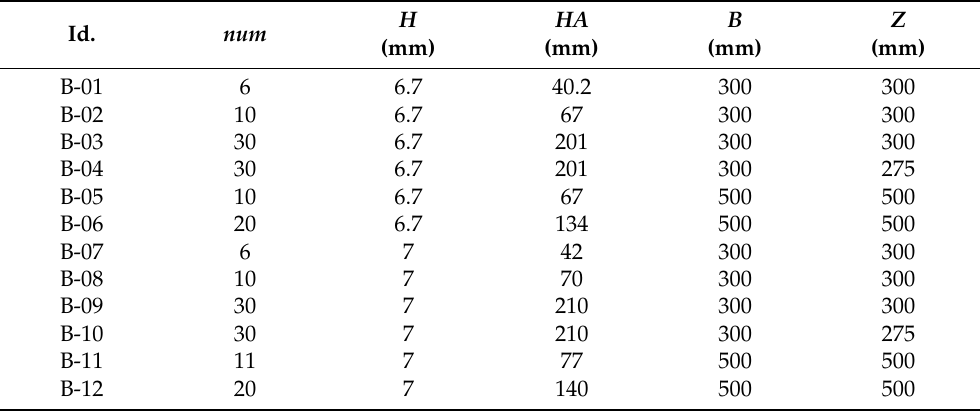
Table 2. Data for the tested cardboard